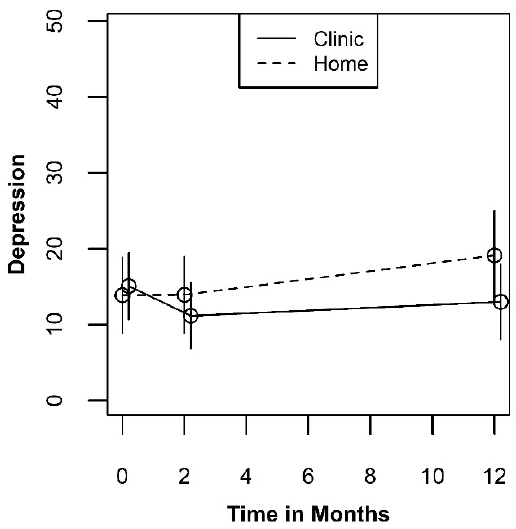
Figure 6. Plot of the two-way interaction for depression by time.